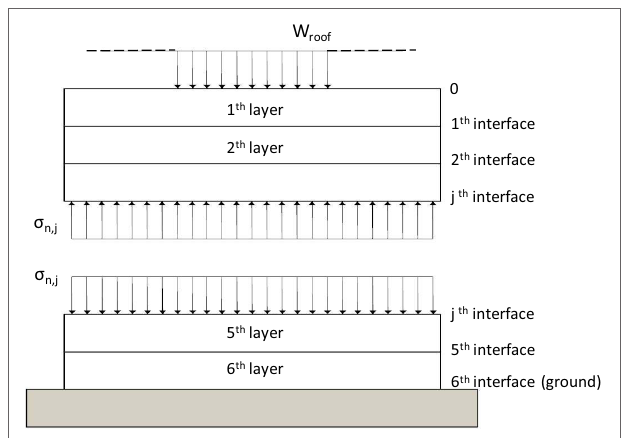
FIGURE 5 | Normal stresses acting on each interface between the gabion-box layers.